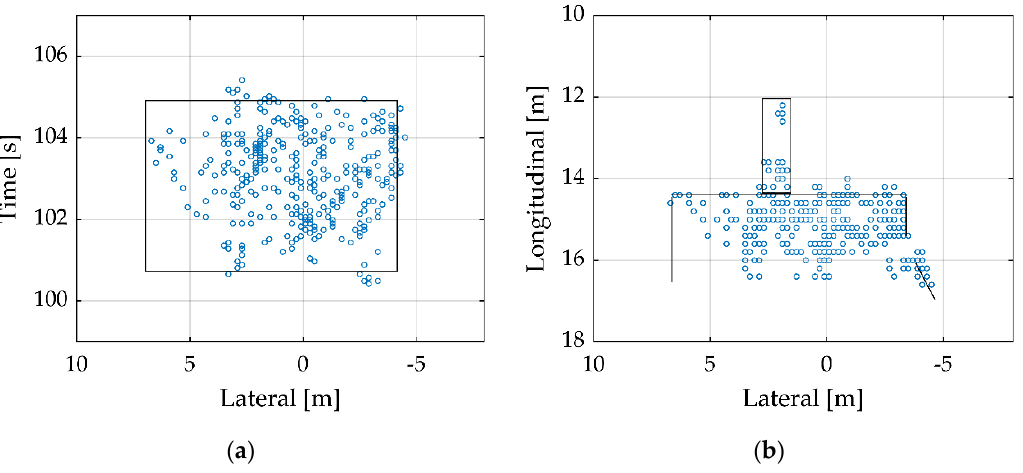
Figure 6. Reconstructed building with radar cluster data (blue points) and manually added building contours (black lines). Only the rooftop is visible. ( a ) View from the top, ( b ) view from the front. Table 4. Comparison of the winery dimensions and the measured dimensions from the radar data. Building